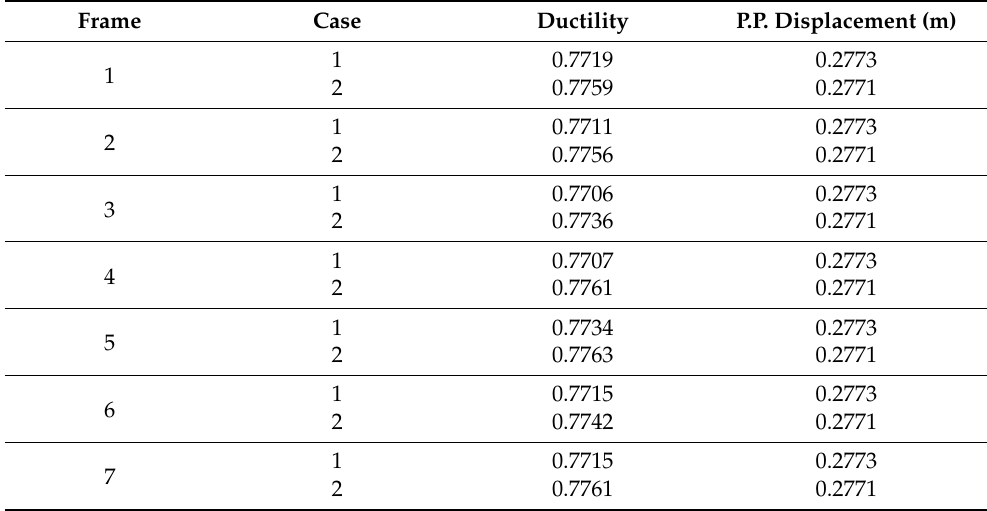
Table 5. Results of the pushover analysis including the load of the overhead crane.